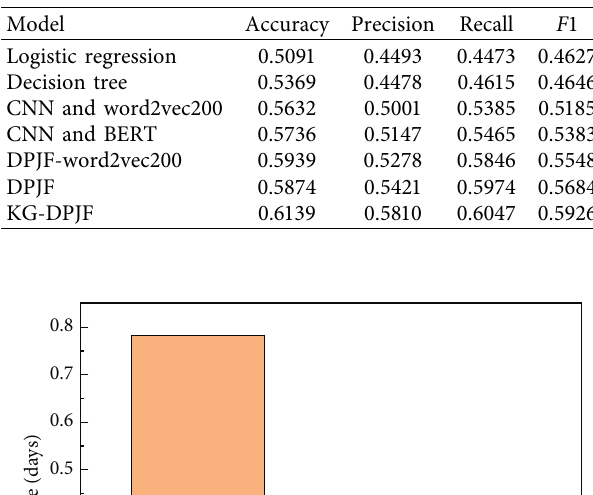
Table 4: Experimental performance table—no structured data.